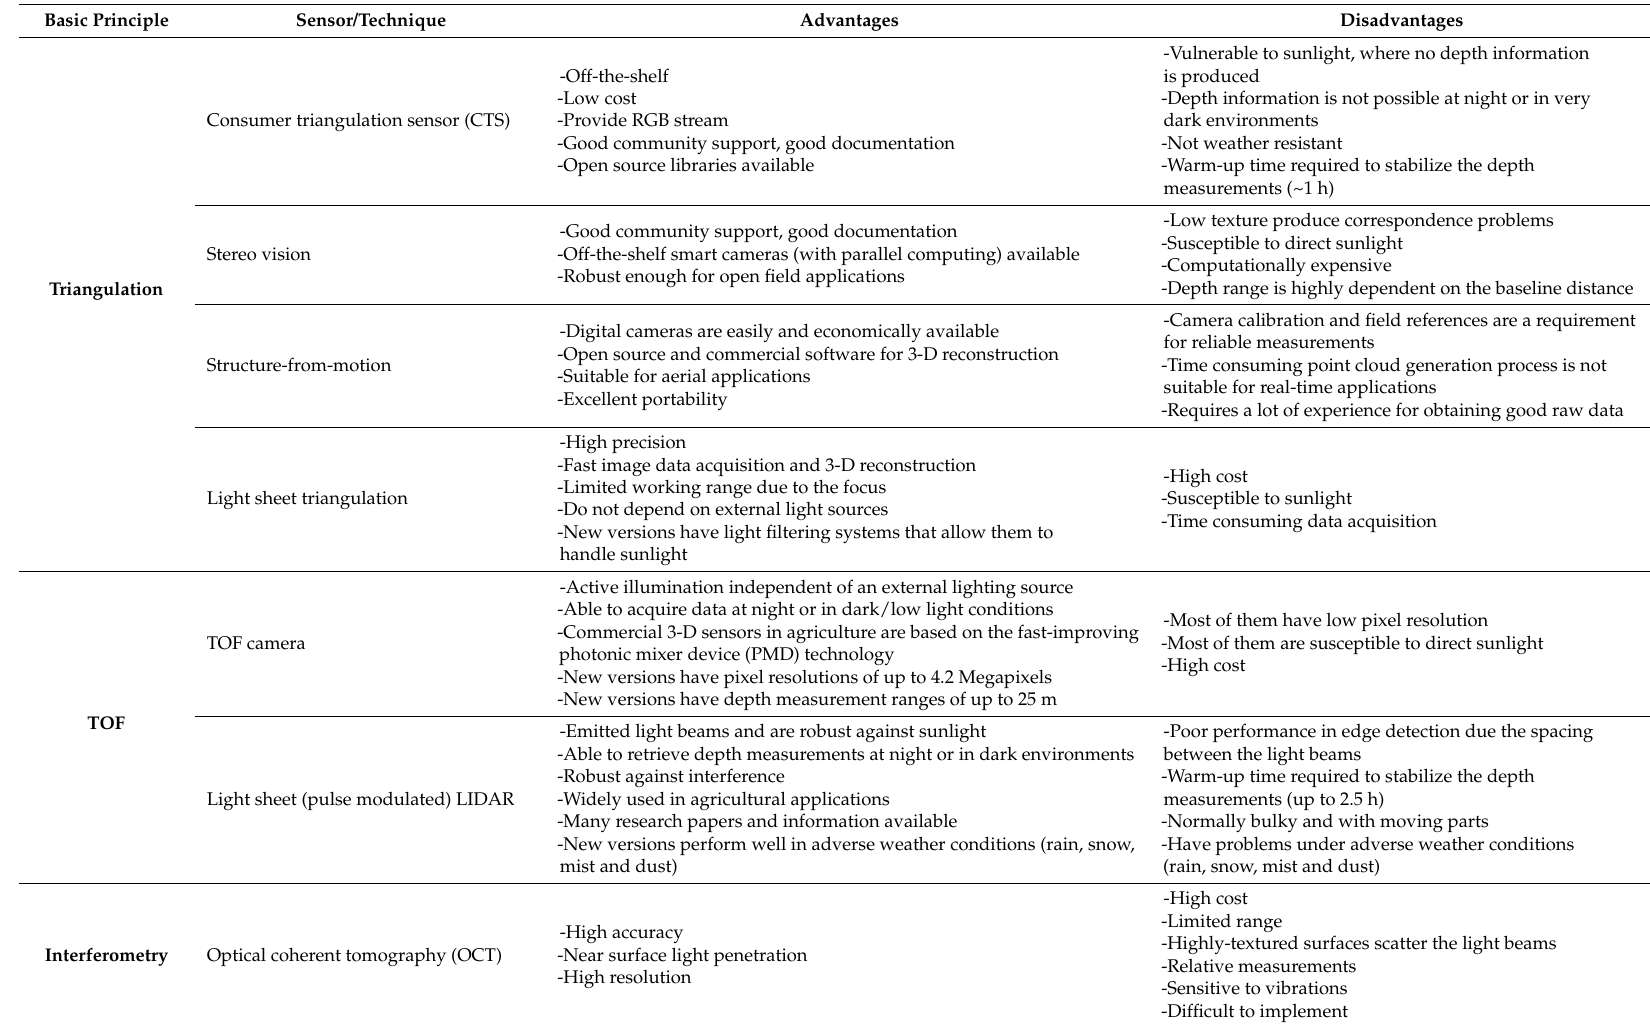
Table 2. Advantages and disadvantages of the most common sensor implementations, based on the basic principles for 3-D